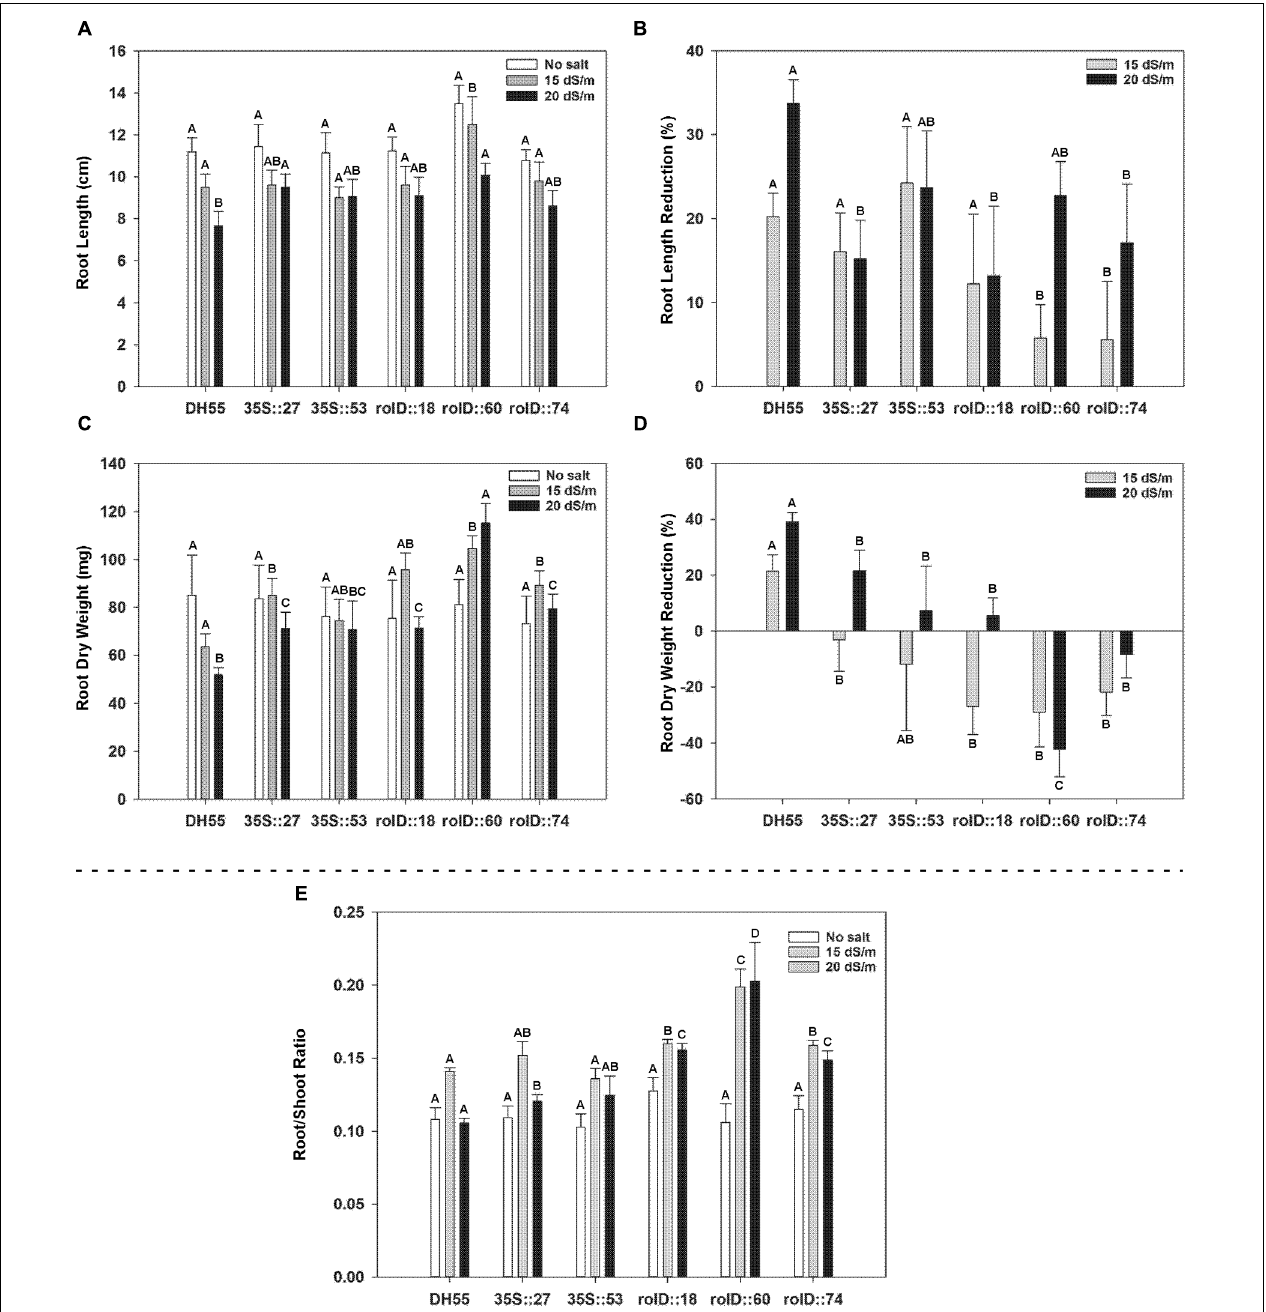
FIGURE 10 | The effect of acdS expression on root development of camelina plants grown in the absence, or presence of, salt (15 and 20 dSm − 1 ). Lines tested include wild-type C. sativa DH55 or independent, single insert, homozygous transgenic lines expressing the acdS gene under the control of the root-specific rolD promoter or the constitutive CaMV 35S promoter. Panels show root length (A) , root length reduction (B) , root dry weight (C) , root dry weight reduction (D) , and ratio of root weight to shoot weight (E) 41 days after sowing. Error bars indicate standard error ( n = 10). A two-way ANOVA and Tukey post-test were used to detect significant differences between groups. Capital letters above bars indicate values that are significantly different ( p < 0.05) between lines for each salt concentration.